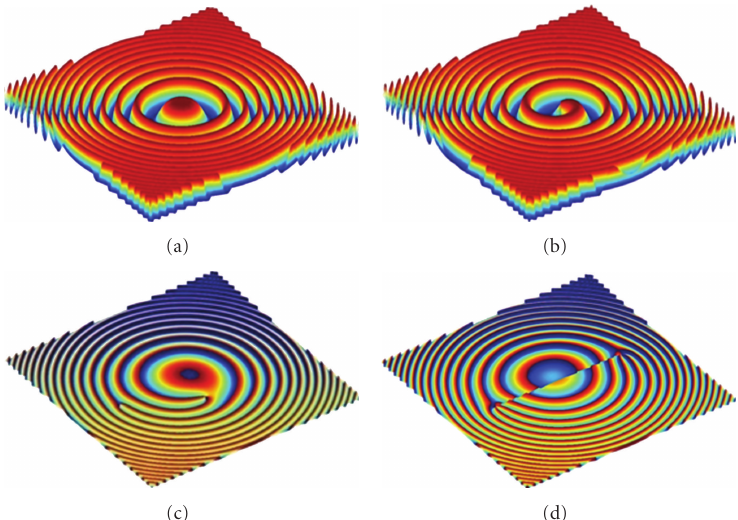
Figure 1: (a) Surface profile of a conventional Fresnel lens. (b) Surface profile of a Fresnel vortex lens. (c) Surface profile of a Fresnel lens with vortices embedded at o ff -axis locations. (d) Surface profile of a Fresnel lens with half-integer vortices embedded at o ff -axis locations.